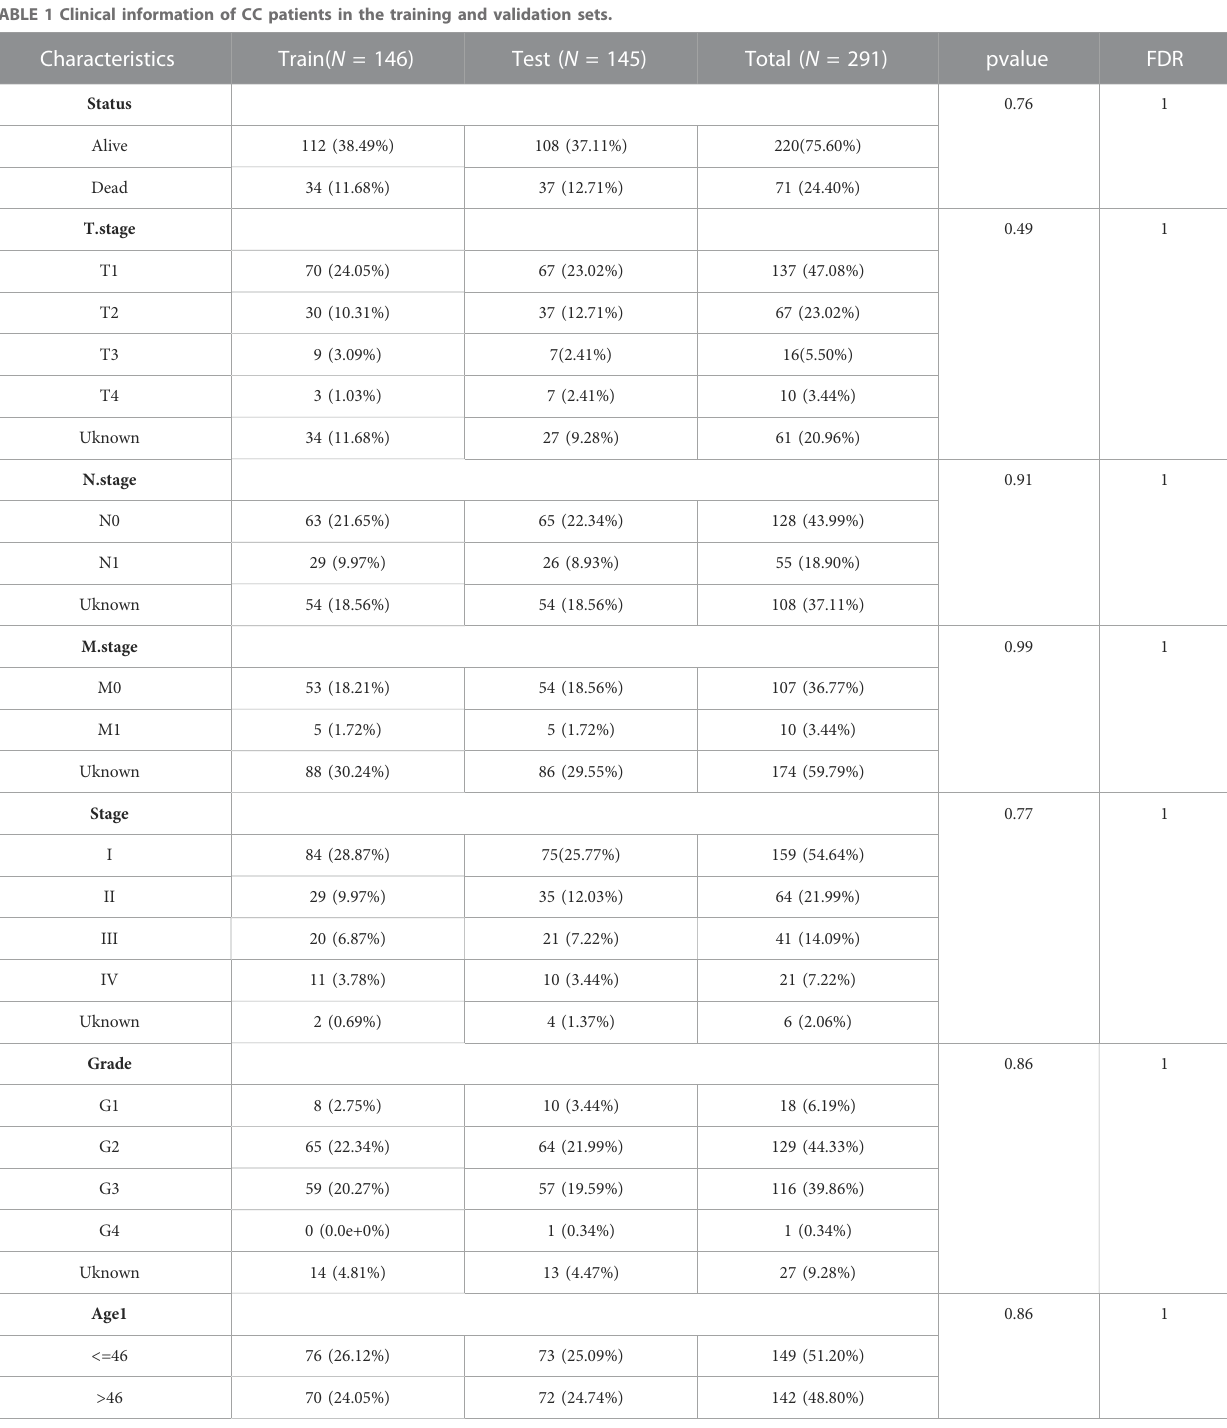
TABLE 1 Clinical information of CC patients in the training and validation sets.